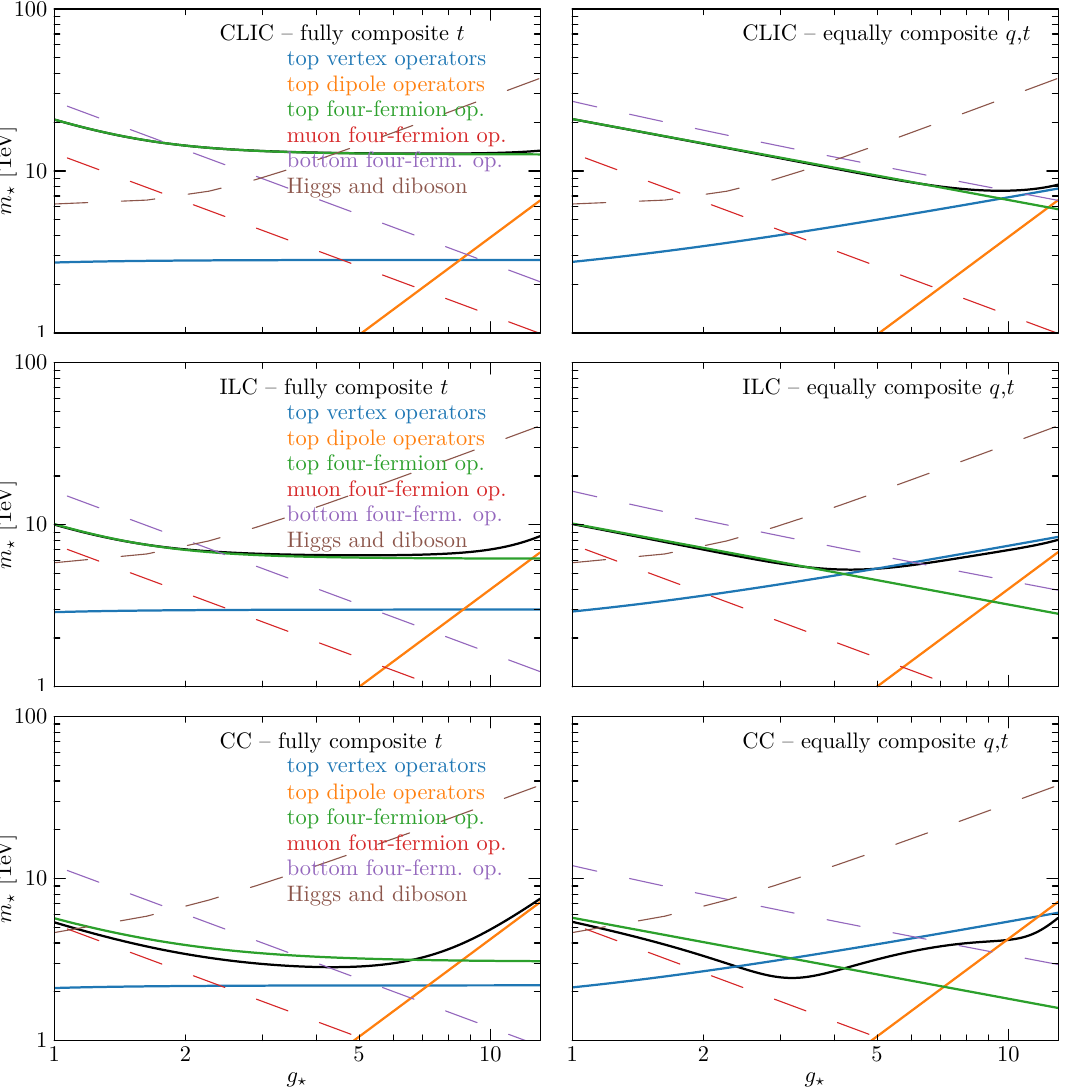
Figure 1 . Five-sigma sensitivities in the g ? ; m ? parameter space of CH models, deriving from statistically optimal observable measurements in top-quark pair production, when one single type of operators is considered at a time. The region below the black line is probed by top-quark production measurements, once all types of operators are combined. Correlations sometimes make this combination less sensitive than subsets of operators. The constraint arising from the universal contribution to four-fermion operators involving two electrons and two muons are displayed with a dashed red line. The dashed violet line derives from constraints on four-fermion operators involving two electrons and two bottom quarks. Higgs and diboson measurements [36, 37] discussed below cover the region below the dashed brown curve. For simplicity, the power counting of table 1 is assumed to predict operator coe(cid:14)cients